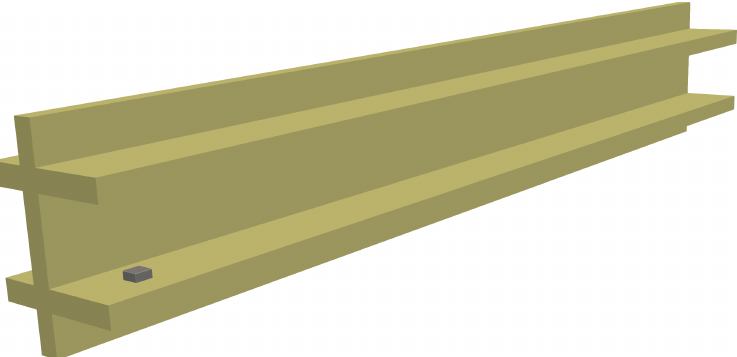
Figure 2. Channel model featuring a single PM layer fragment in gray. Dark yellow structures represent porous filter substrate.